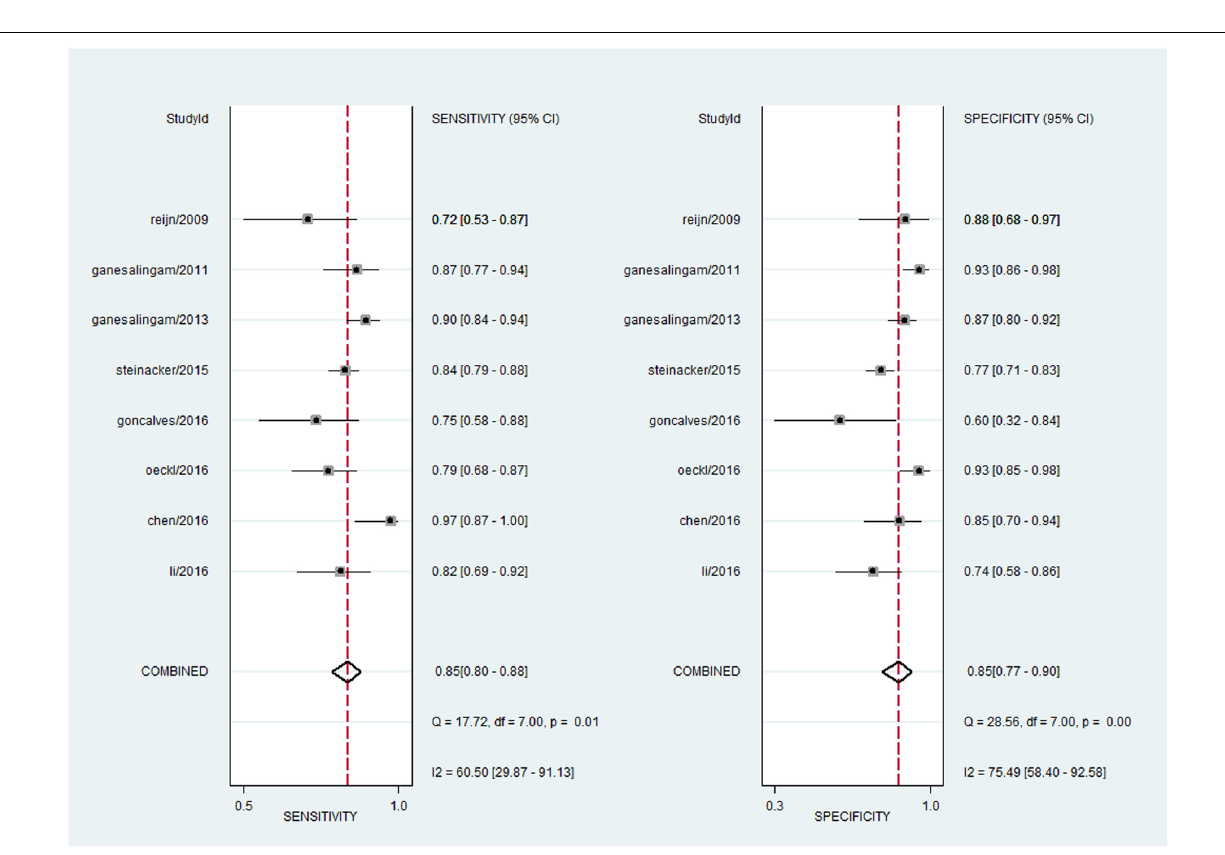
Frontiers in Aging Neuroscience |